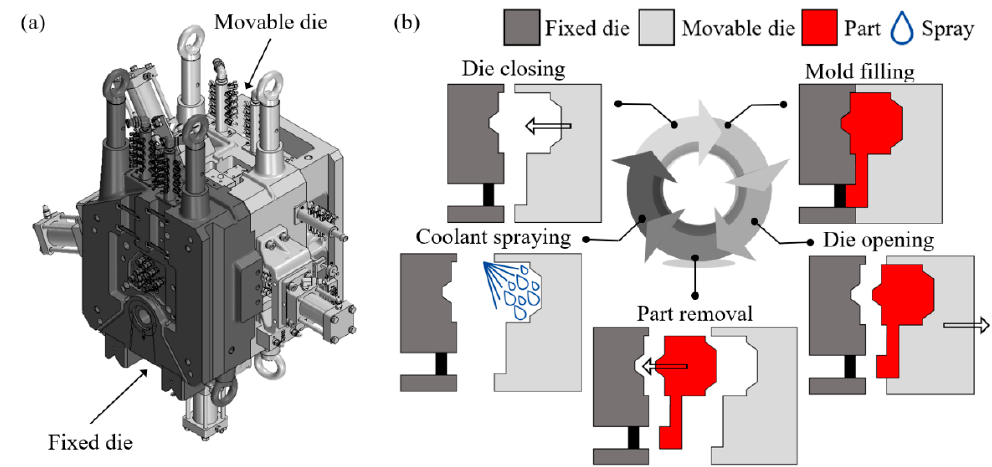
Figure 4. Die casting process overview. ( a ) Movable and fixed die. ( b ) The one-cycle process chain of HPDC.